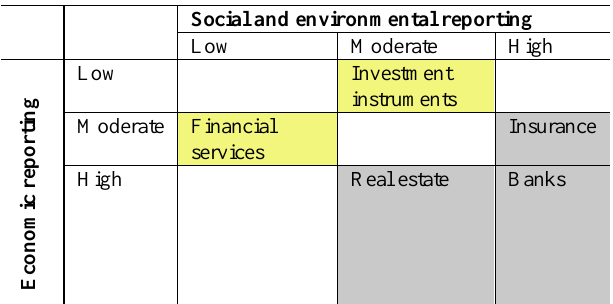
Table 5: Financial v non-financial reporting